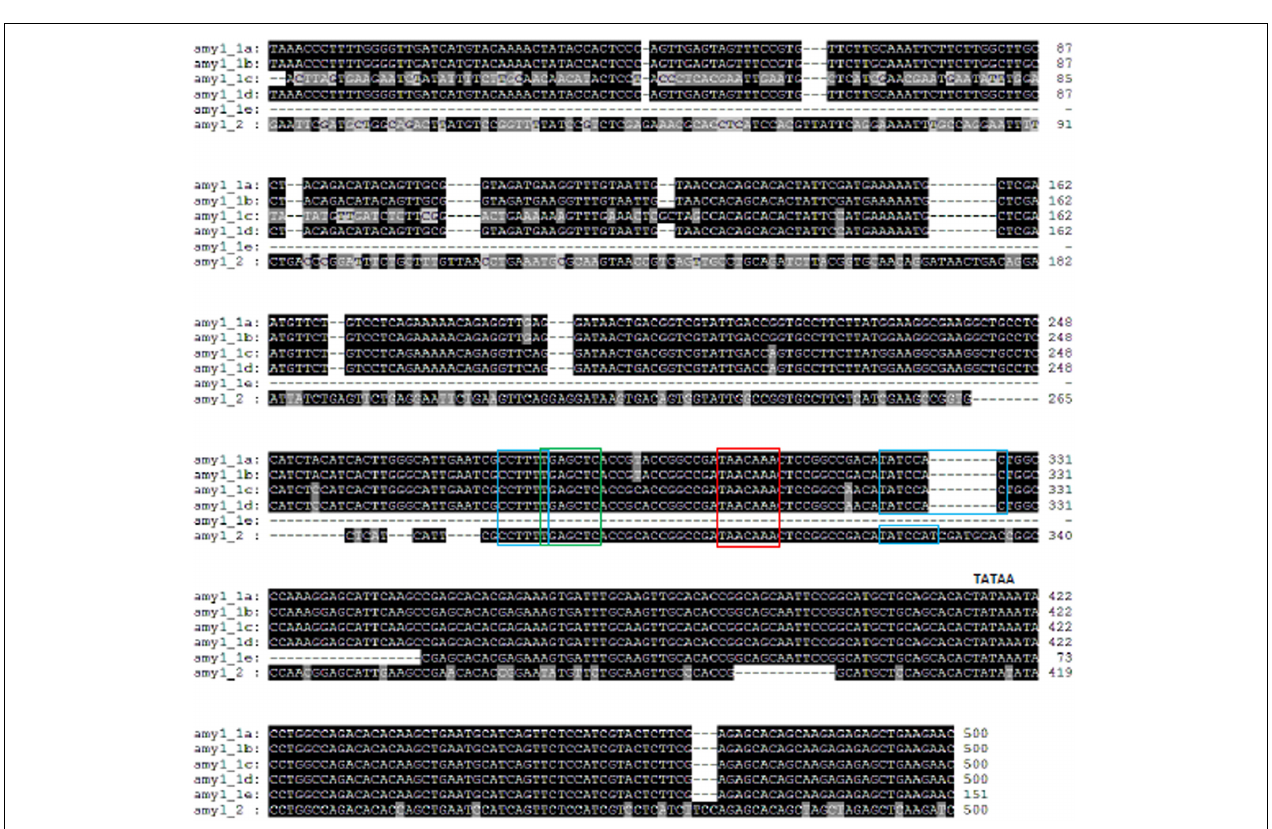
FIGURE 2 | Barley amy1 promoter sequence alignments and conserved motifs. ALL amy1 promoters (except amy1_1e , which is truncated) contain a GA-responsive element (GARE) TAACAAA (red box). It requires for GA induction, They also contain a pyrimidine box (CCTTTT) and a TATCCA(C/T) box (blue boxes), which enhance gene expression after GA responses (Gubler and Jacobsen, 1992). A cAMP-like responsive element (TGAGCTC) is conserved (green box).